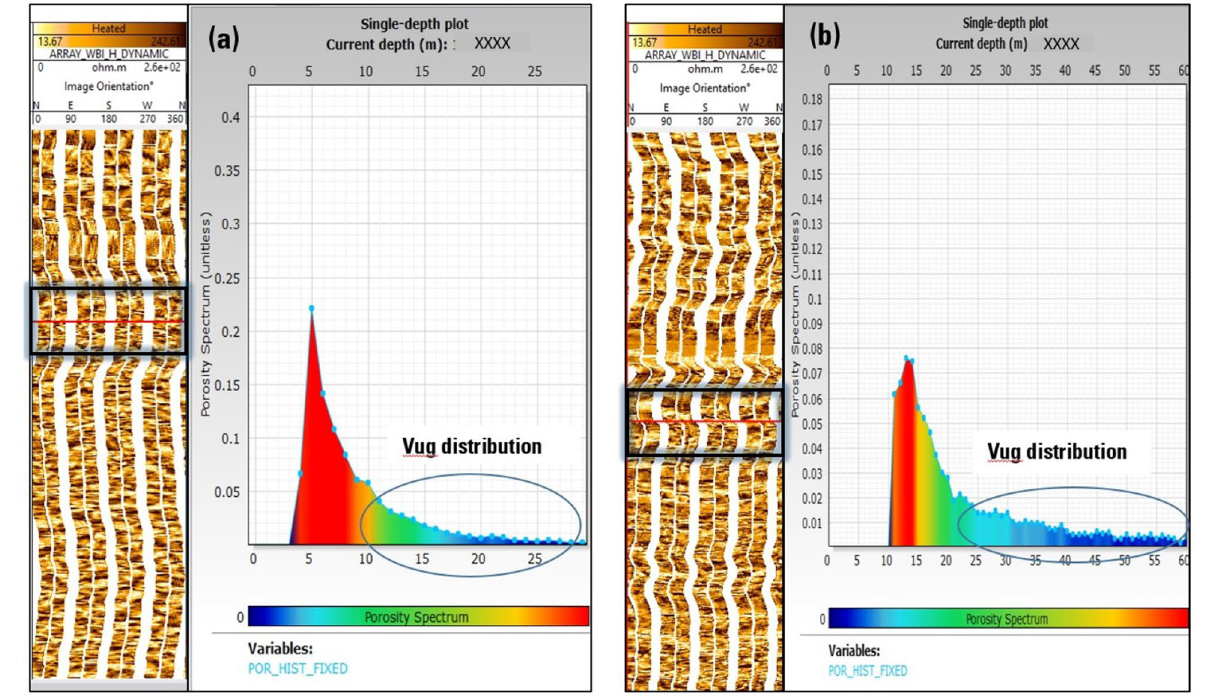
Fig. 2 Distribution of porosity type. Shows mostly secondary type of porosity (huge amount of vug) in a Mauddud Formation and b U. Shuaiba formation in well #2